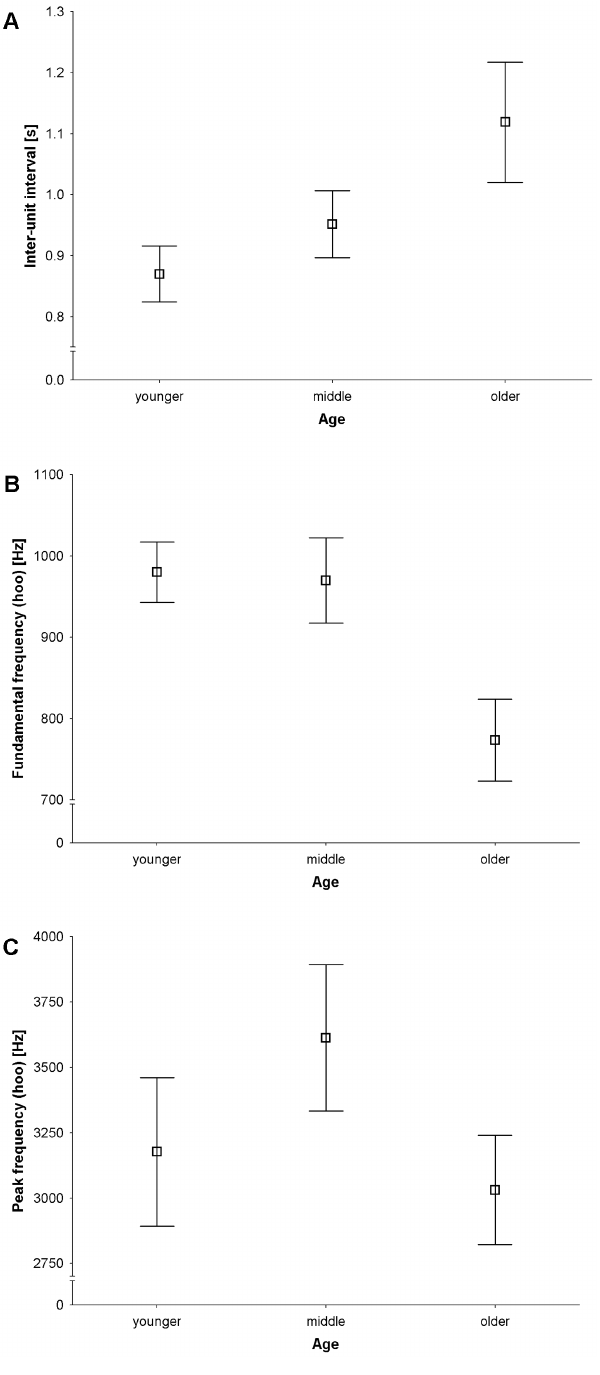
Figure 7. Mean ± 95% confidence interval of three parameters that varied significantly across age classes: (A) inter-unit interval, (B) fundamental frequency of hoo syllables, and (C) peak frequency of hoo syllables.